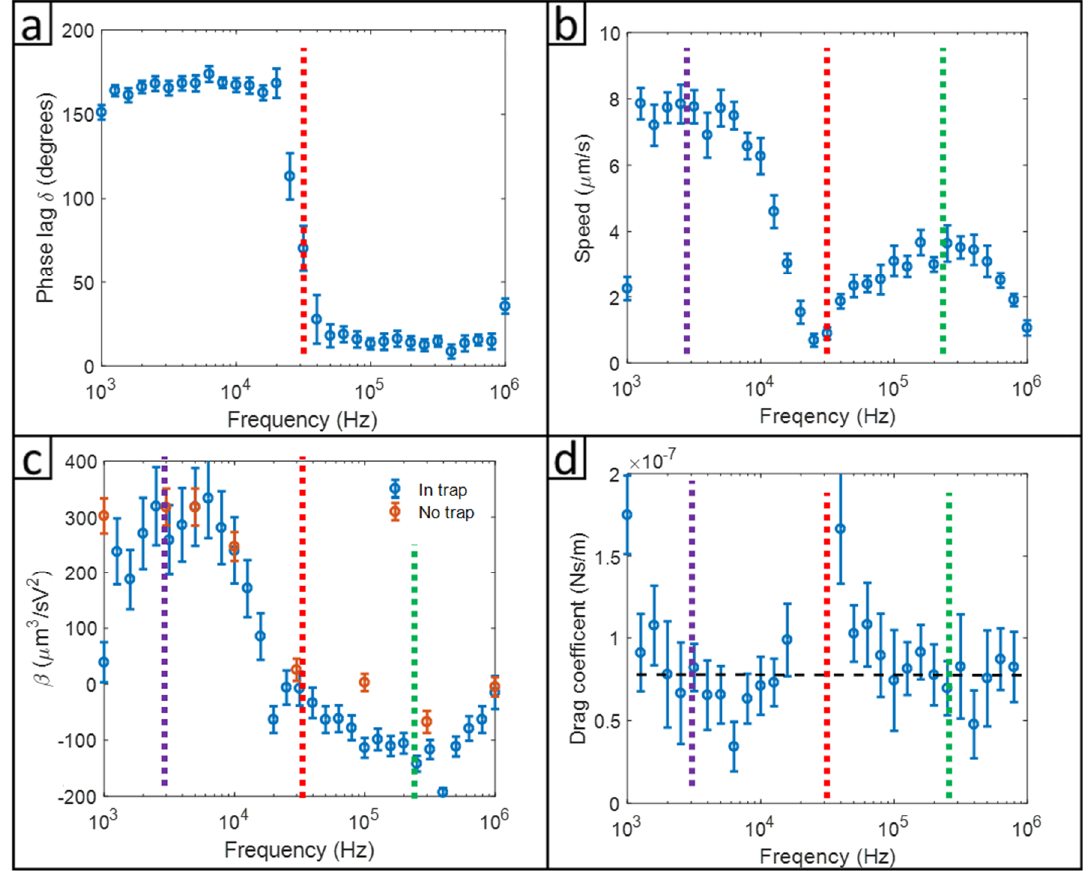
Figure 6. Experimental results of PFS at 0.1 V/ μ m of the carrier frequency of the electric field from 1 kHz to 1 MHz with 1 Hz amplitude modulation frequency at 30% modulation amplitude. The vertical dash rad lines ( f c ) represent the crossover frequency at 27 kHz. The vertical dash green line ( f r ) represents the maximum reversal velocity at 220 kHz. The vertical dash purple line ((cid:1858) (cid:3033) ) represents the maximum forward velocity at 1–5 kHz. ( a ) Phase delays of a 3 μ m Janus particle. ( b ) Speeds of the same 3 μ m Janus particle. ( c ) Comparison of the Beta values of the Janus particles measured with trapping (Equation (3)) and without trapping. ( d ) Drag coefficients determined from the phase delay data.